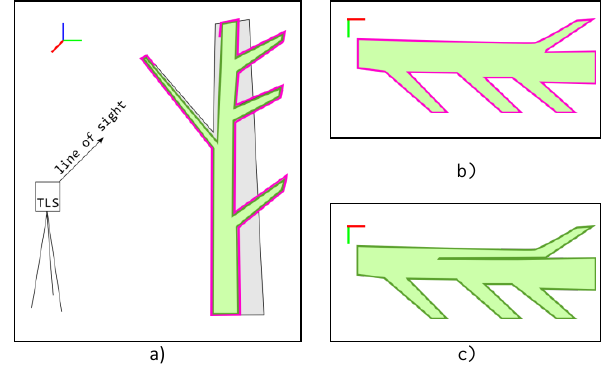
Figure 3. a) Scanner view of real-world tree. b) Normal tracing of component boundary without inner contours. c) Boundary tracing with inner edges caused by depth